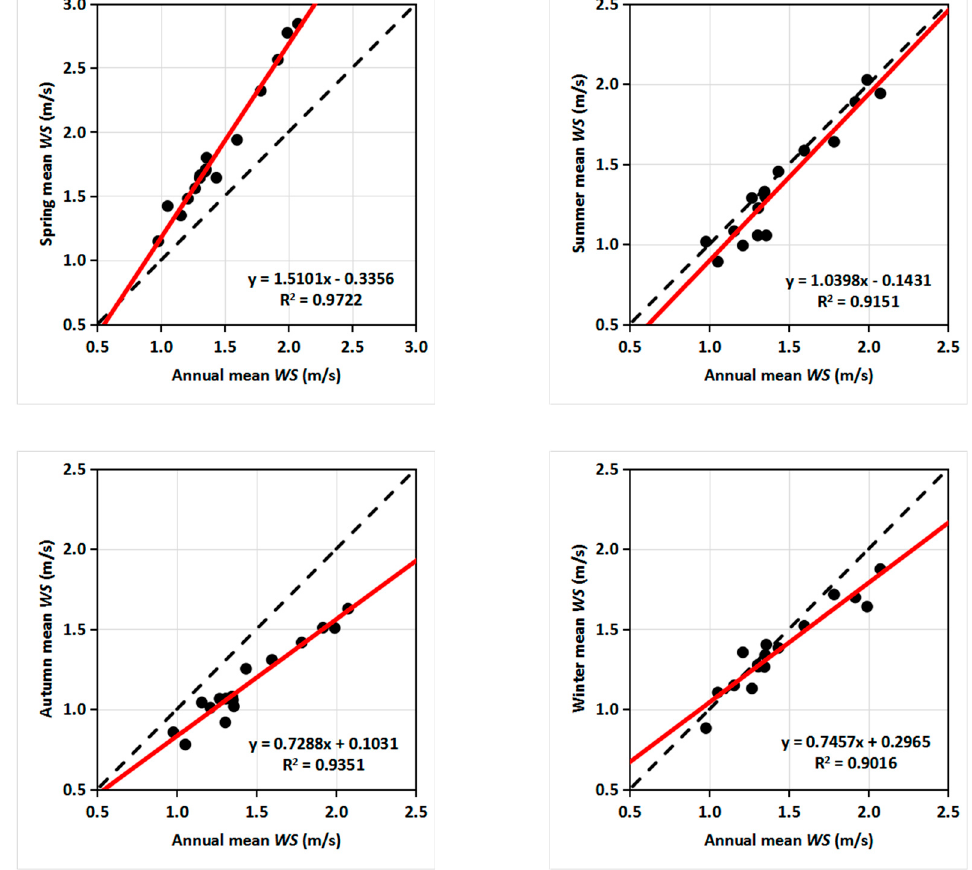
Figure 4. Seasonal mean wind speed at the 16 stations and local climate zone ventilation performance sequences.